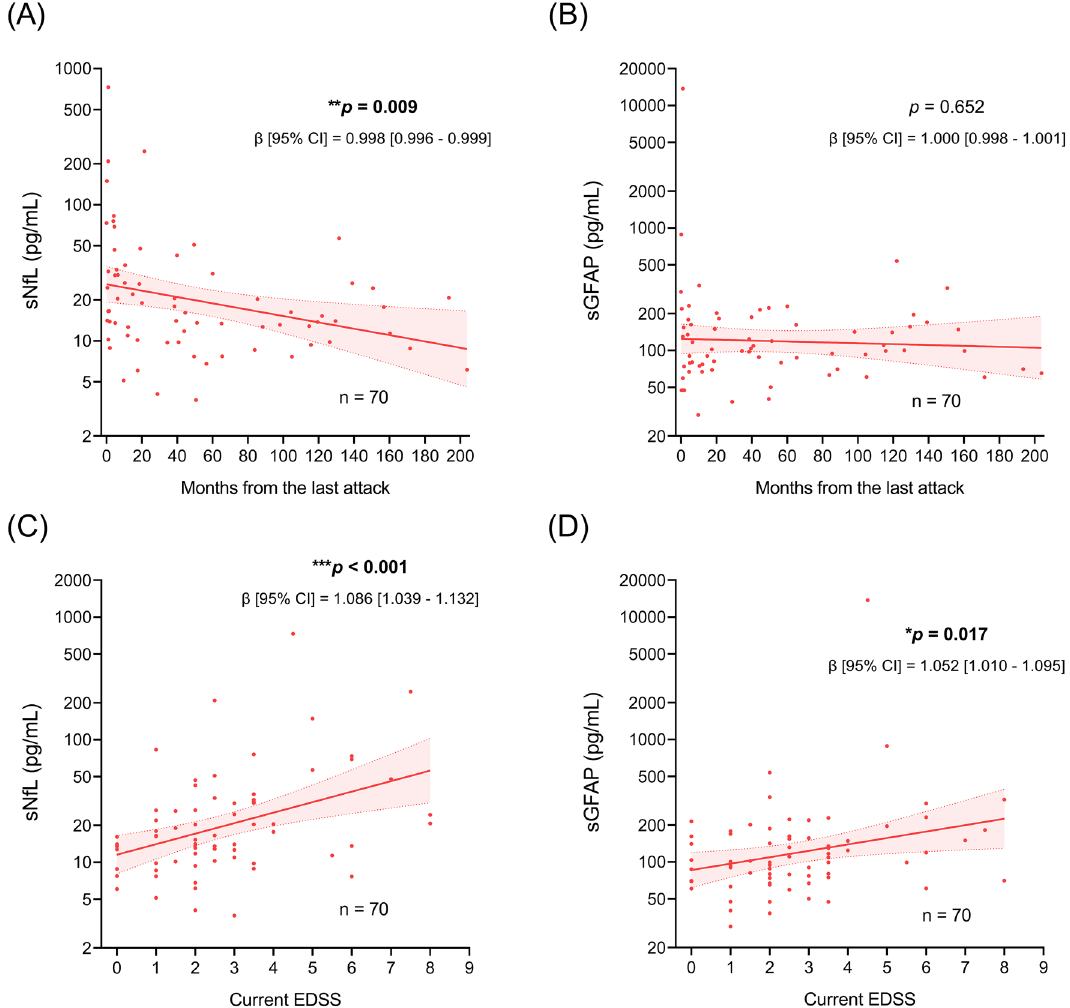
Figure 3. Associations between serum biomarkers and clinical parameters. ( A , B ) Associations between serum biomarker levels and attack-to-blood sampling intervals in ITM patients (n = 70). ( C , D ) Associations of serum biomarkers with EDSS scores in ITM patients. Regression lines and p values are derived from simple linear regression models. Translucent bands indicate 95% CI. β reflects multiplicative effects because the endpoint sNfL and sGFAP were log-transformed. p values with statistical significance (* p < 0.05, ** p < 0.01 and *** p < 0.001) are presented in bold. sNfL: serum neurofilament; sGFAP: serum glial fibrillary acidic